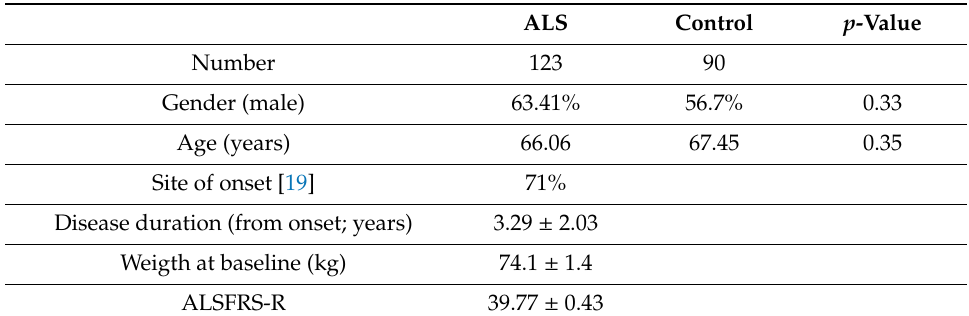
Table 1. Characteristics of amyotrophic lateral sclerosis (ALS) patients and controls at the time of cerebrospinal fluid (CSF)